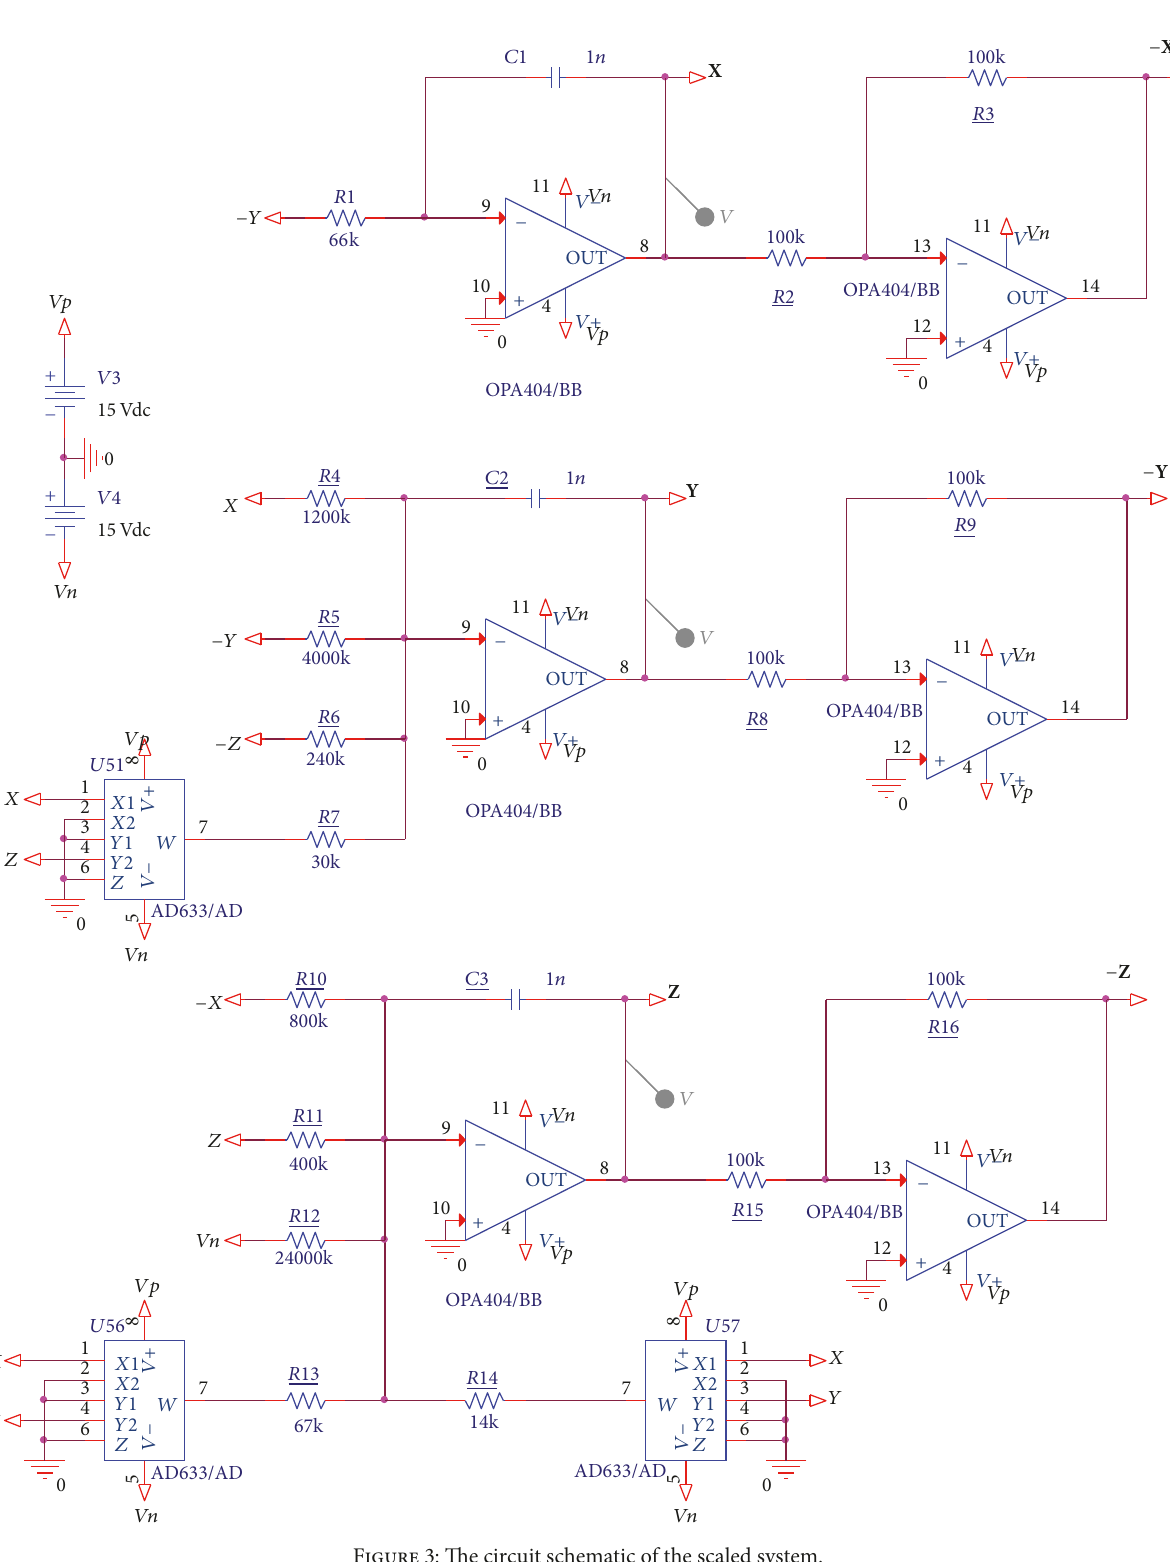
Figure 3: The circuit schematic of the scaled